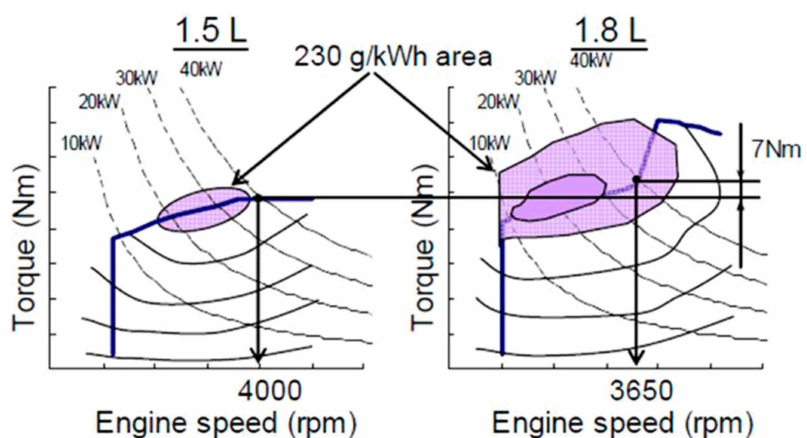
Figure 11. Performance Map of 1.8 L vs 1.5 L